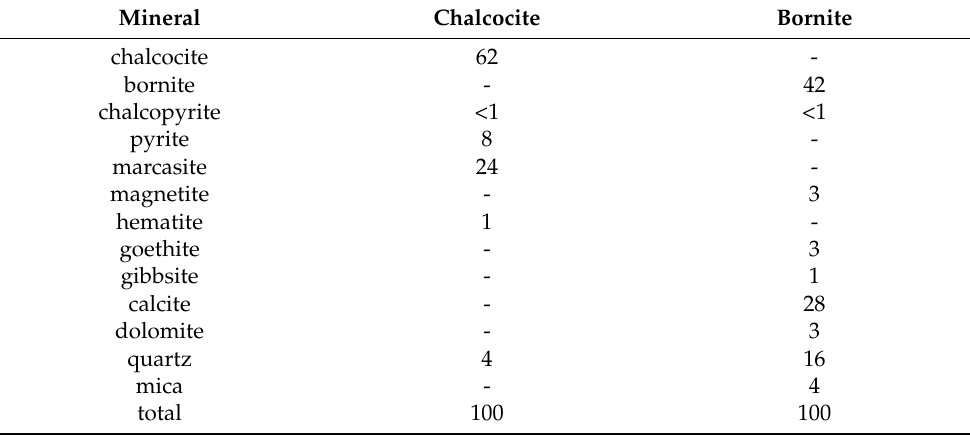
Table 1. Bornite and Chalcocite Sample Mineralogy.